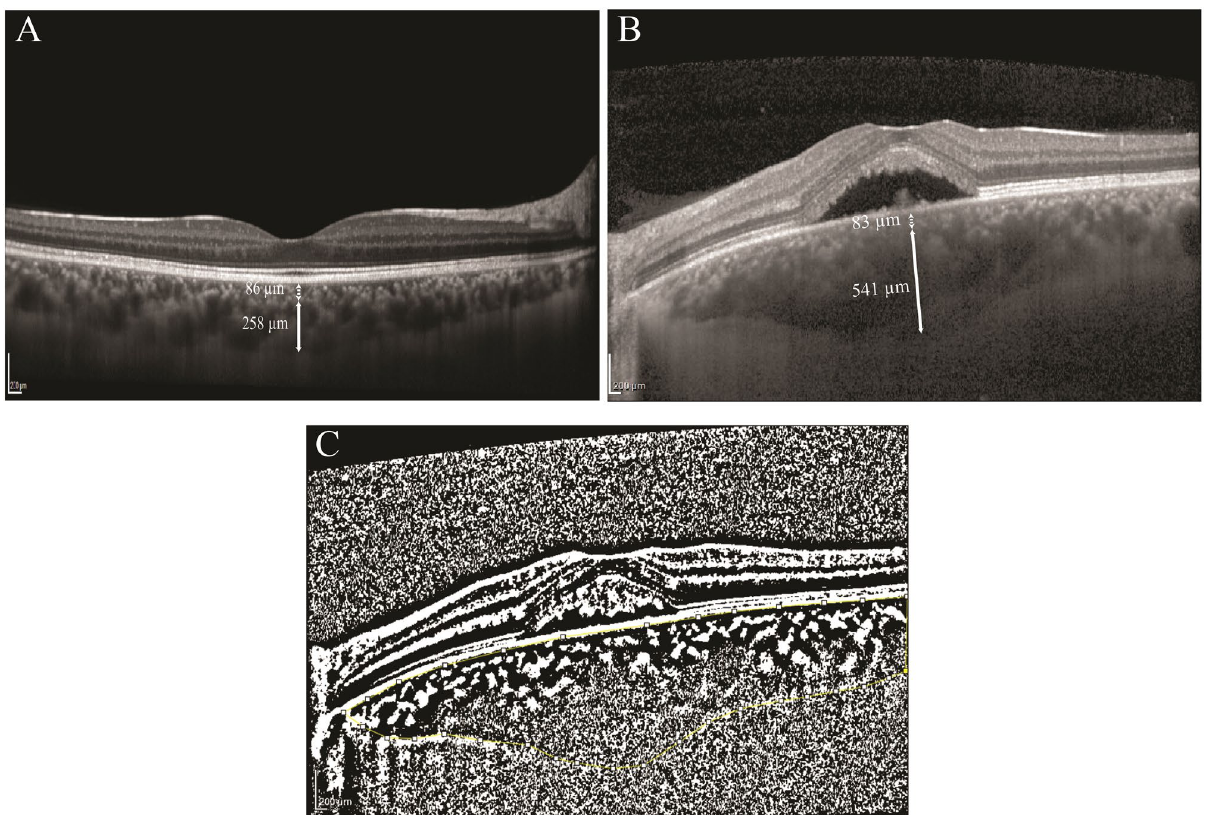
Figure 2. Choroidal thickness and vascularity index measurements. Haller layer (solid arrow) and the Sattler- choriocapillaris (dotted arrow) thickness manual measurements in enhanced depth imaging-optical coherence tomography of a healthy subject ( A ) and a patient with central serous chorioretinopathy ( B ). The Niblack’s autolocal thresholding method was used for binarization of the image. Then, subfoveal choroidal area was selected using the polygon tool (yellow dots). The dark pixels were selected using the color threshold tool and the area occupied by the dark pixels was defined as the luminal area. ( C